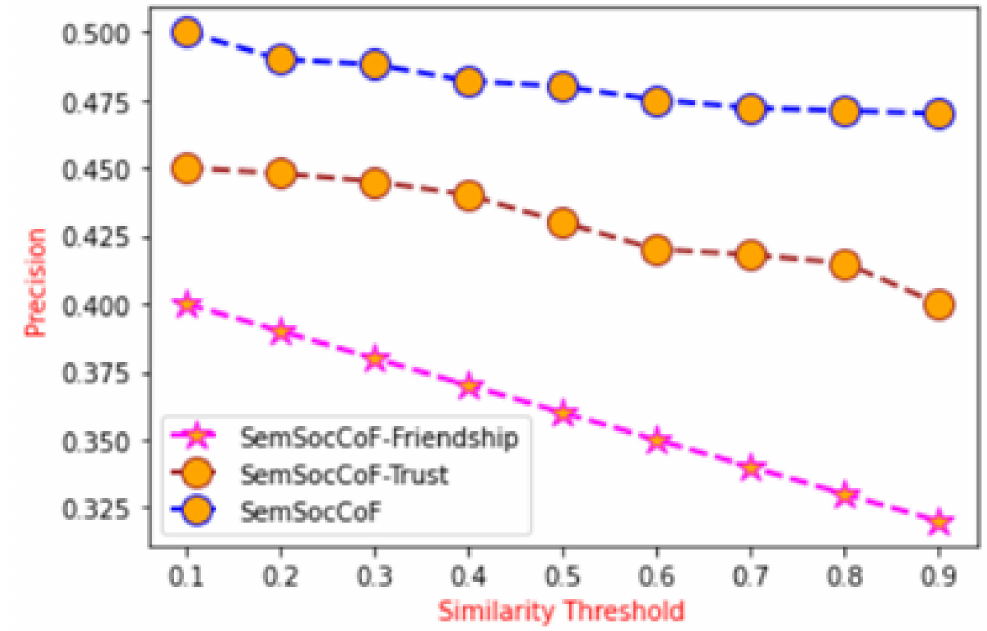
Figure 16. Credibility information contribution in the recommendation